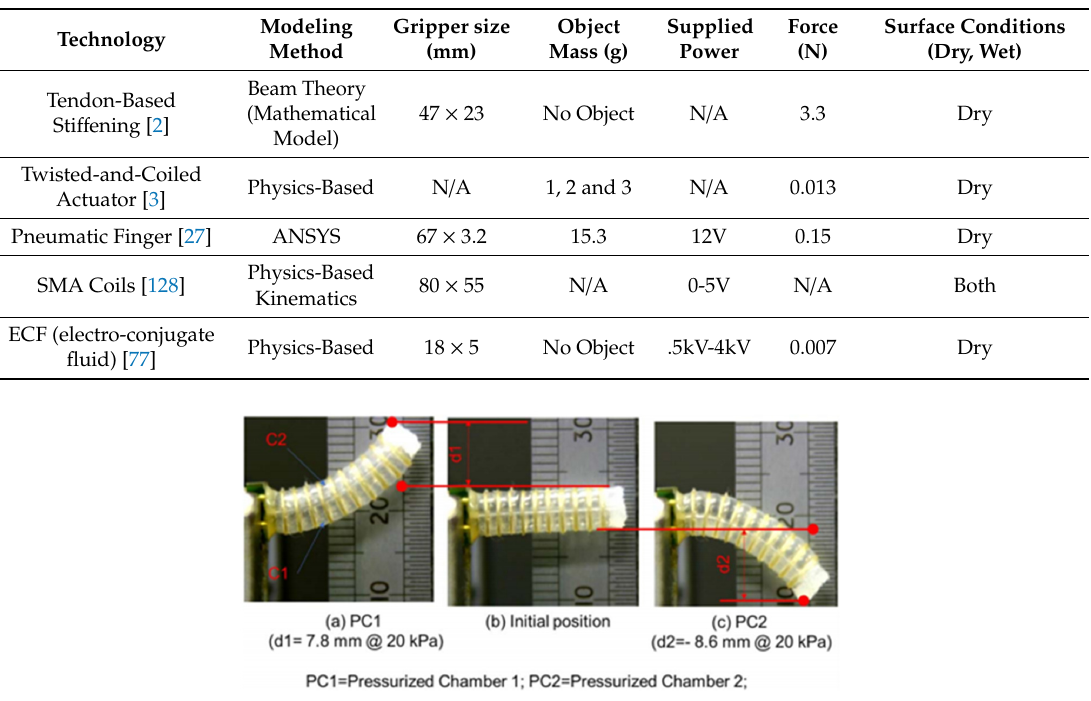
Table 3. Summary comparing di ff erent soft robotic technologies.